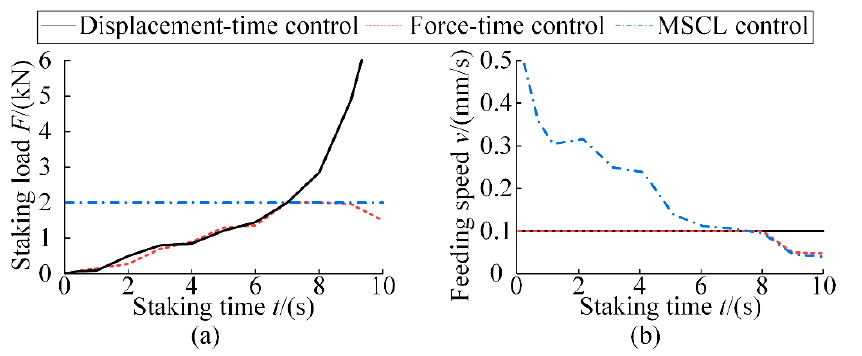
Figure 10. Qualification rates of different quality indexes under three loading control methods: ( a ) Staking load–time curve; ( b ) Feeding speed–time control. Table 3. Comparison of the process characteristics and staking quality inspection results of the three process-loading control methods.